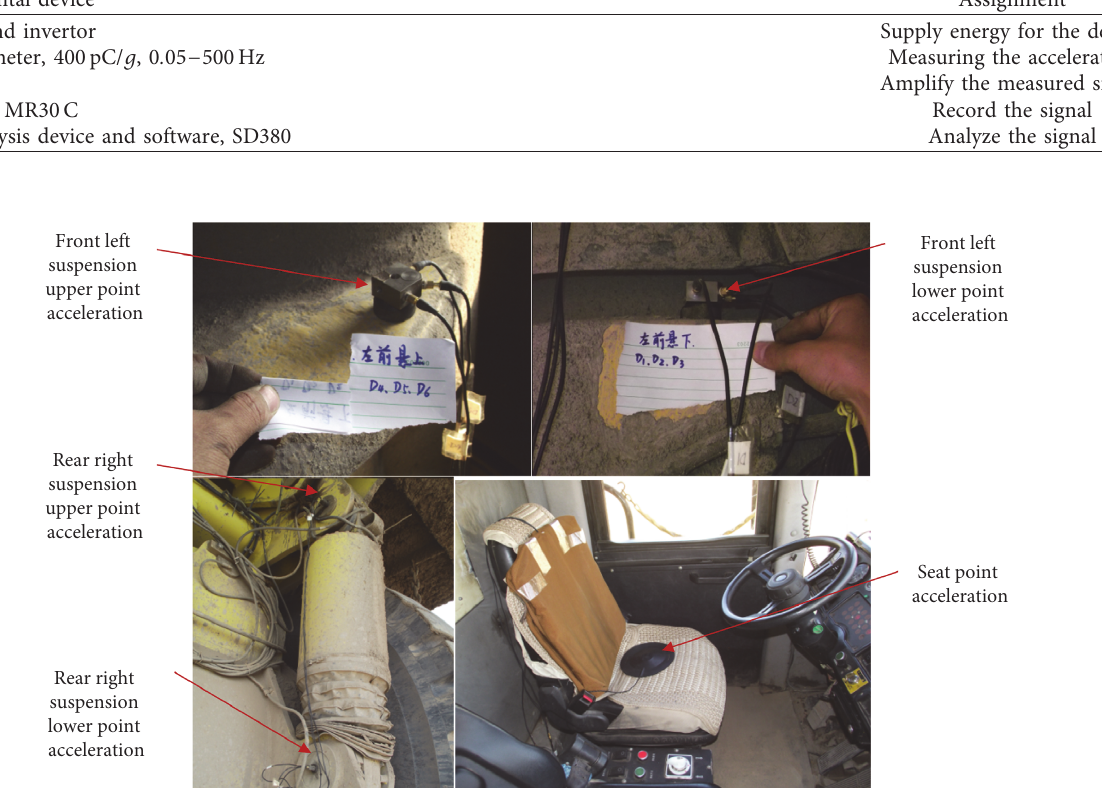
Figure 18: Measurement points of experiment.